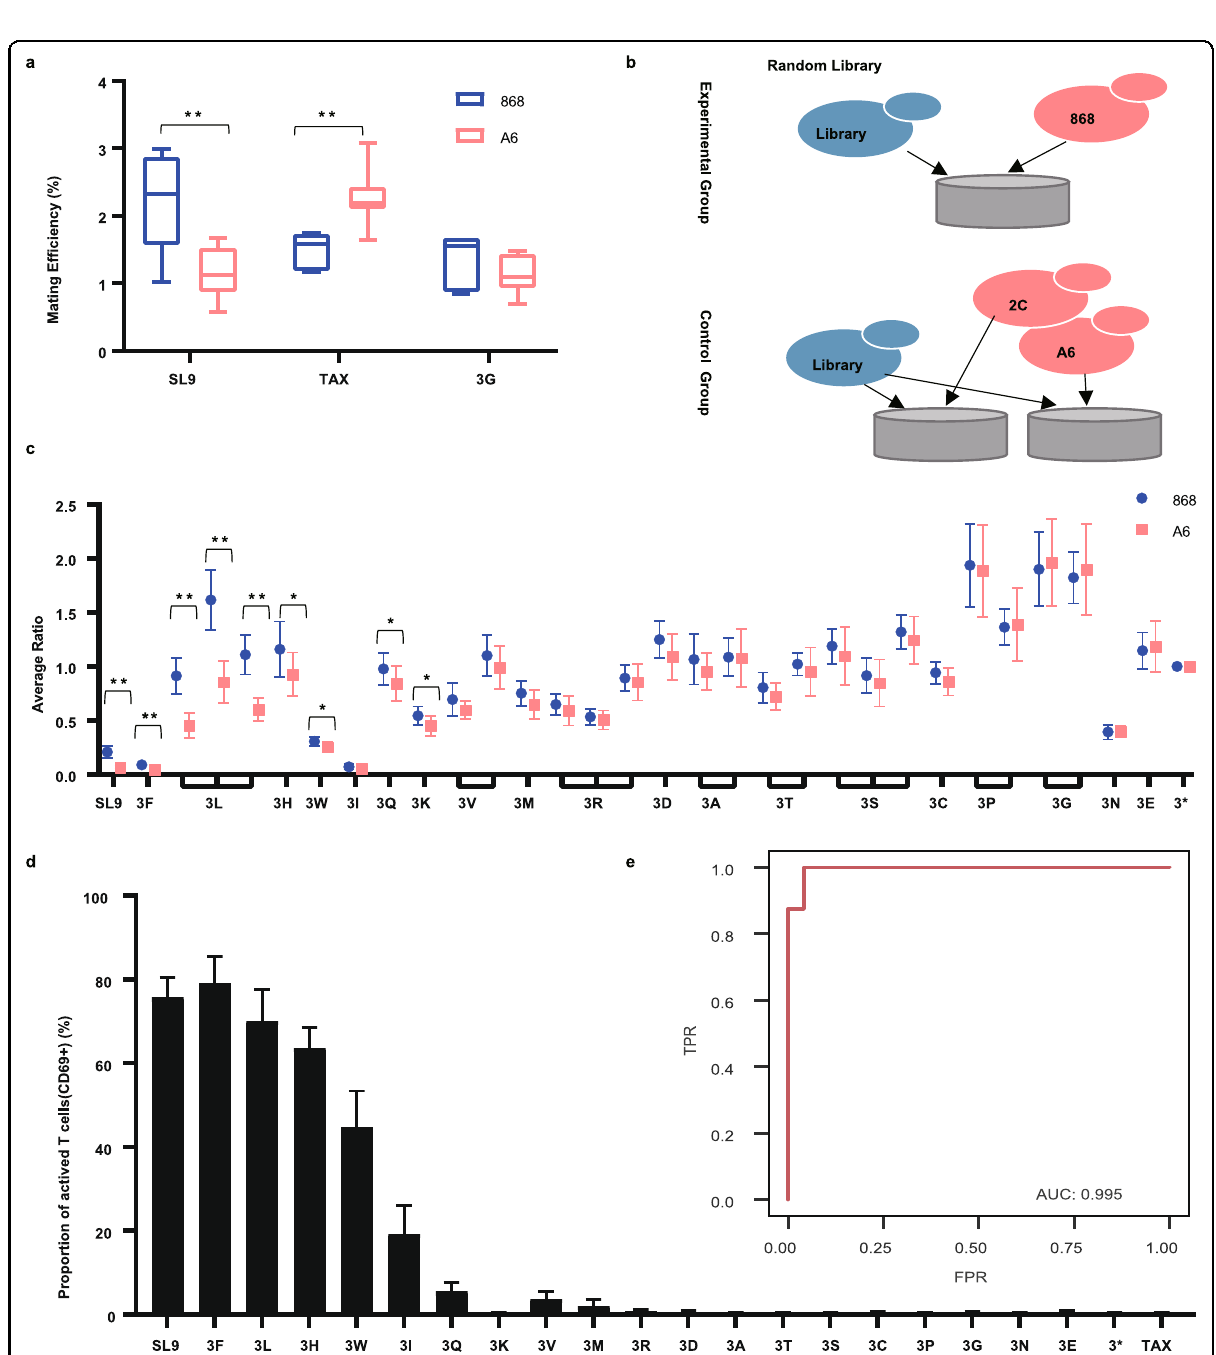
Fig. 3 The YAMTAD system can be used to screen cognate peptides for a given TCR. a The mating ef fi ciency (mean ± sd) between the cognate TCR-pMHC pairs was signi fi cantly higher than that of the negative control pairs. The mating ef fi ciency was calculated by the percentage of diploids detected by FACS. Seven biological repeats were measured. b A schematic diagram of the strategy used for screening cognate peptides for a given TCR in a randomly generated peptide library. The random peptide library was mated with MATa yeasts expressing the 868 TCR as the experimental group and with MATa yeasts expressing the A6 or 2 C TCR as the control group. c Ratios (mean ± sd) of the indicated SL9 mutants to the 3* peptide in diploid yeasts induced in YAMTAD screening. Each experiment was performed with 4 technical repeats and was independently duplicated 3 times. The mean of 12 duplicates is shown. d Proportion (mean± sd) of 868 T cells activated by various SL9 mutants in the yeast T cell co-culture system. The Y-axis represents the proportion of activated T cells (CD69 + ) after coculturing with the indicated yeast strains. e The ROC curve depicting the FPR (false-positive rate, 1-speci fi city) and TPR (true positive rate, sensitivity) for library screening of TCR-pMHC interactions using the YAMTAD system. We de fi ned a peptide as a cognate peptide if it could activate more than 10% of the T cells on average in the yeast T cell coculture assay. Unpaired two- tailed Student ’ s t-test was used for statistical analysis in a , c . **Indicates a two-tailed P value < 0.01. *Indicates a two-tailed P value <